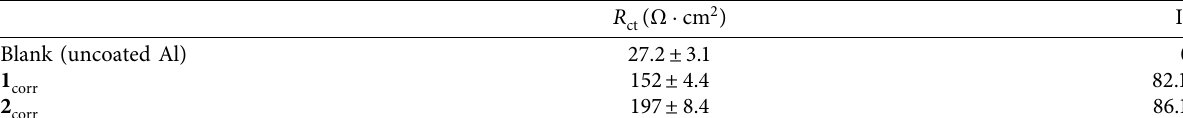
Table 4: EIS data in 1.0 M HCl.